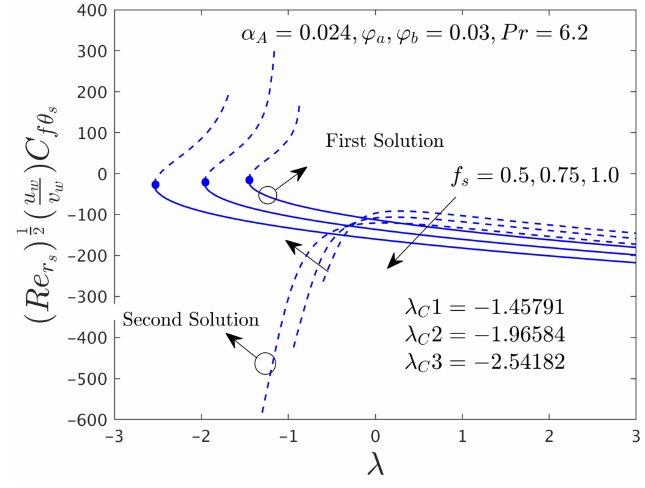
(cid:16) (cid:17) u w C f θ versus λ for numerous choices of f s . v w s s